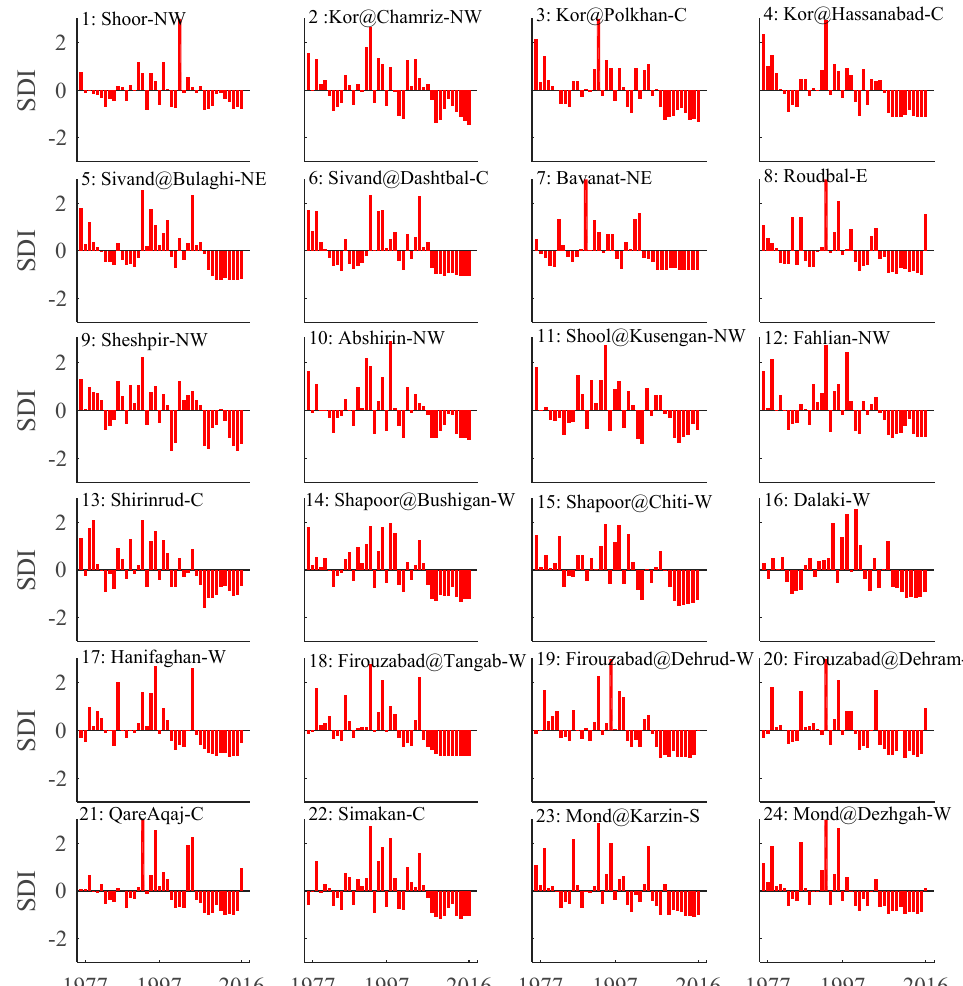
Figure 6. Variation in streamflow drought index (SDI) at 24 gauging stations in the study area. The Kor, Firouzabad, and Mond rivers had more than one selected station, so station names are added. Regions: W: western, NW: northwestern, C: central, S: southern, E: eastern, NE: northeastern. Detailed information on all stations is available in Table A2 in Appendix A.